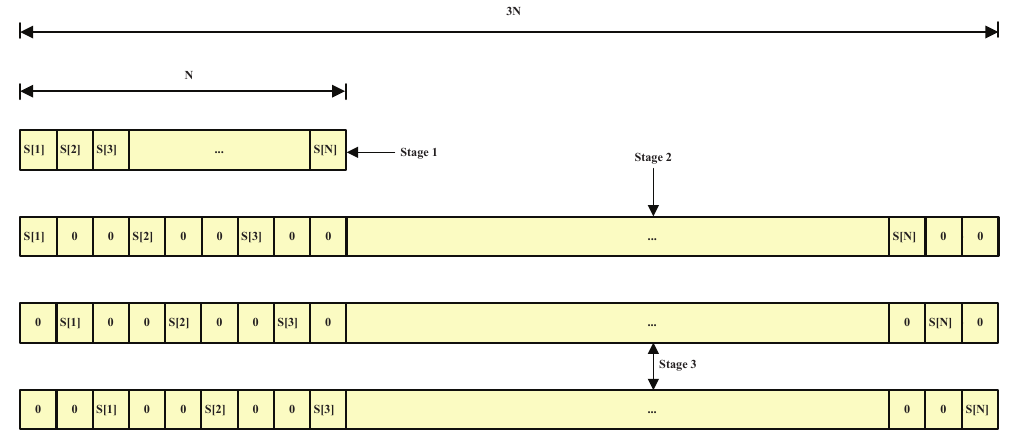
Figure 1. Illustrations of data sequence of discrete spectra allocated to